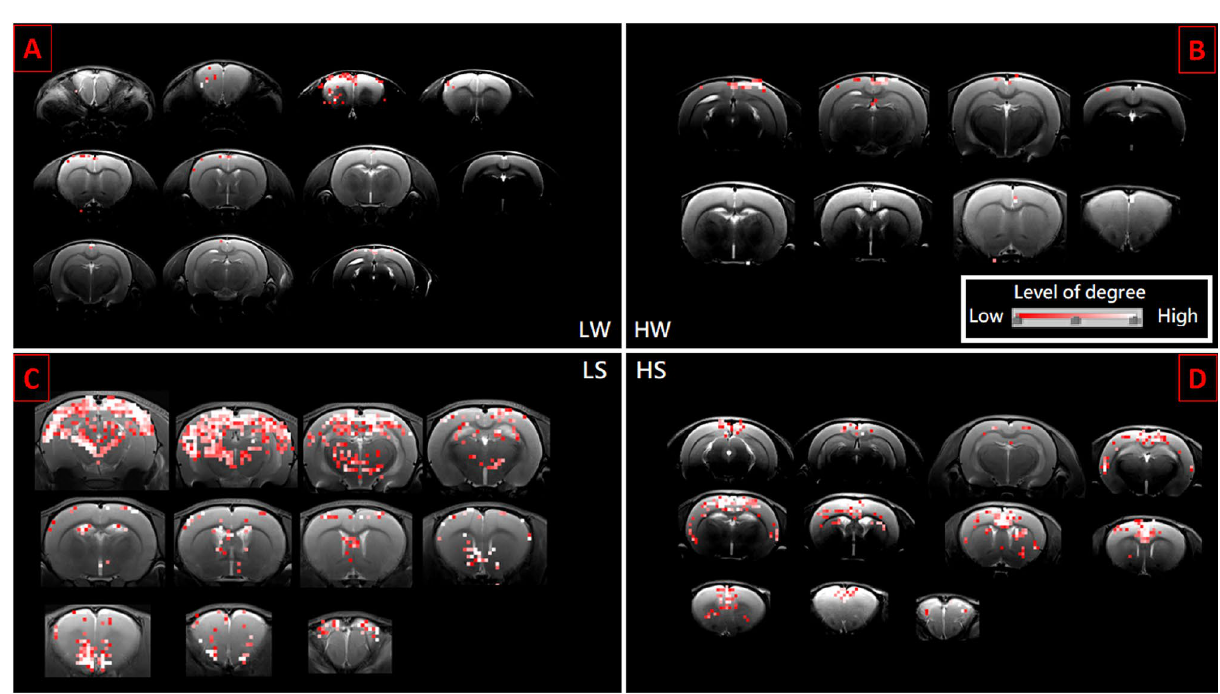
Figure 6. Panels ( A ) to ( D ) illustrate the activated region in LW, HW, LS, and HS states, respectively. The grade of brightness signifies different degrees of connectivity in the cross section. We only show the brain section with